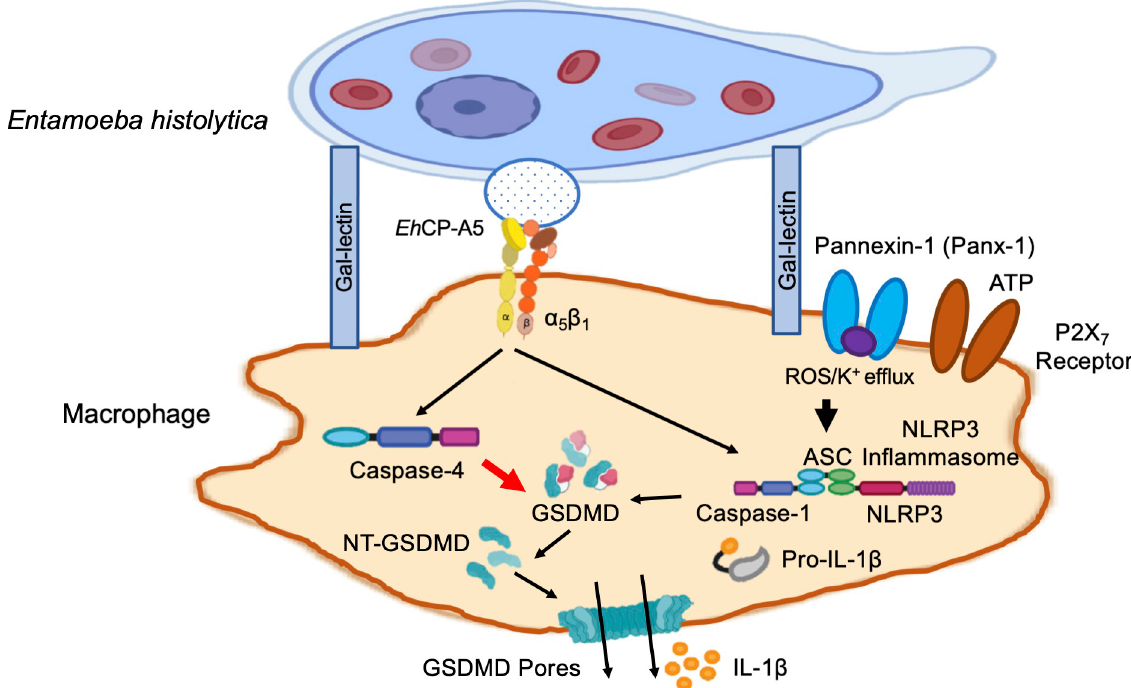
Fig 14. Proposed schematic representation of E . histolytica -macrophage interaction and induction of caspase-4/1 activation and IL-1 β secretion. The activation of caspase is initially triggered by Eh in contact with macrophage via the Gal-lectin to Gal/GalNAc residues on the surface of macrophage. Eh CP-A5 is highly expressed on the surface of Eh and following Gal-lectin binding brings, Eh CP-A5 RGD sequences ligate α 5 β 1 integrin on the macrophage surface to induce the generation of ATP and release through the opening of pannexin-1 channel that subsequently signals back onto the P2X 7 receptor to activate the NLRP3 inflammasome. Simultaneously, K + efflux and the production of ROS collaborate to activate the NLRP3 inflammasome. The NLRP3 inflammasome in turn activates caspase-1, whereas, the activation of caspase-4 is independent of the inflammasome complex. Whereas both caspase-4/1 acted together to induce the cleavage of GSDMD, caspase-4 played a dominant role in this process. The cleaved GSDMD initiates pore formation allowing bioactive IL-1 β release without causing significant cell pyroptosis.